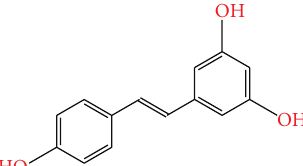
Figure 1: Chemical structure of